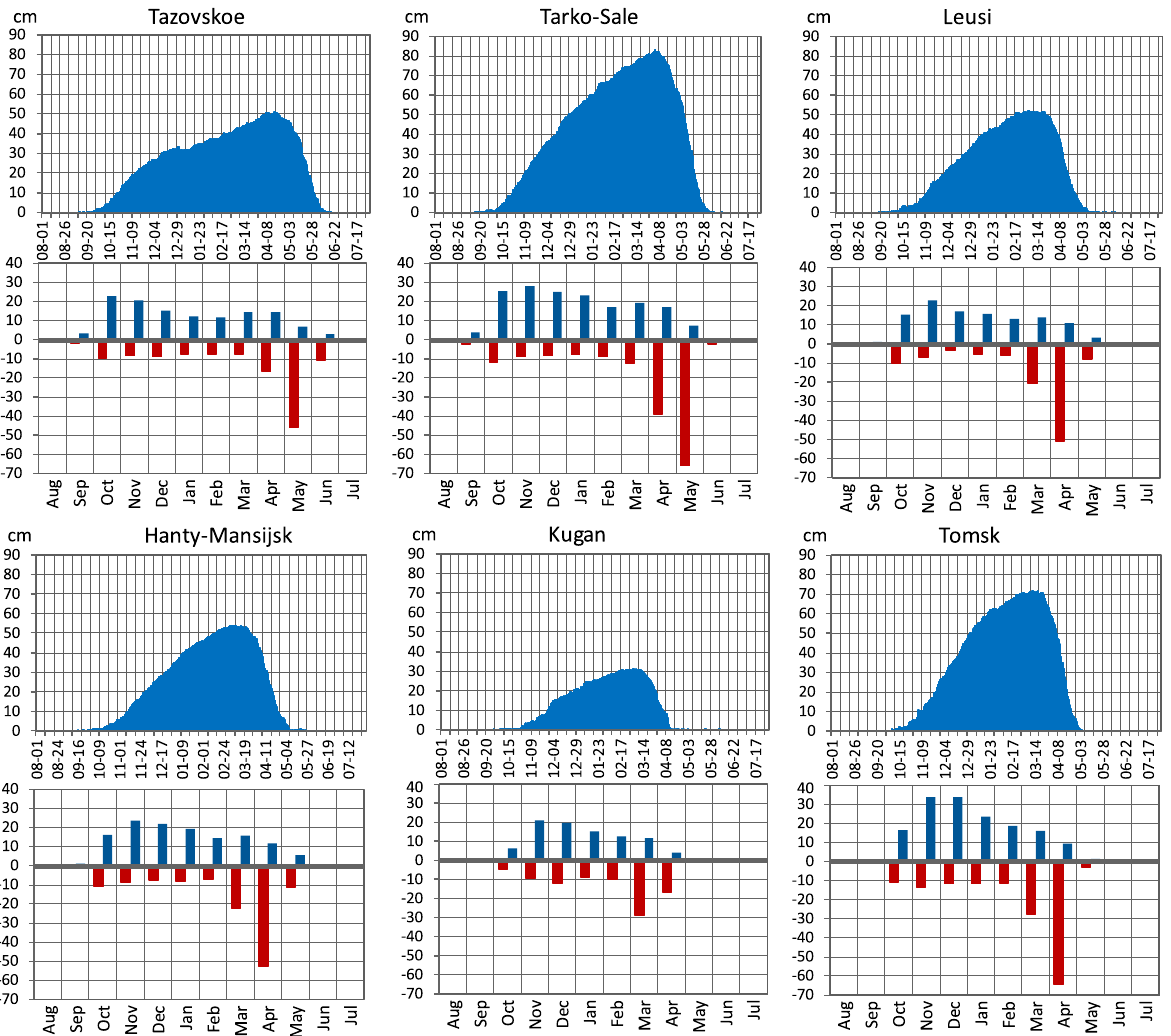
Fig. 2. Upper bar charts—seasonal course of mean daily snow depth (cm); bottom bar charts— mean monthly snow accu- mulation totals in cm (blue bars) and mean monthly totals of decrease in snow depth (red bars) in cm (averages for period 1978–2008 for selected stations).